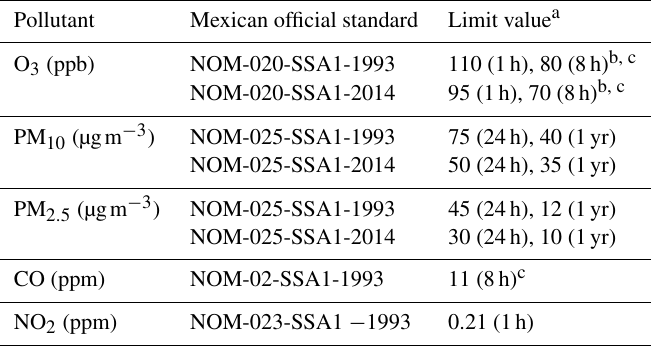
Table 1. Air quality limit values stated in Mexican